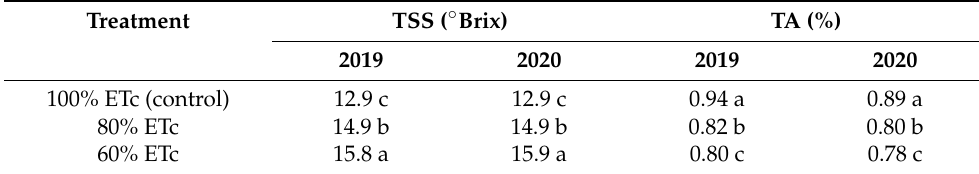
Table 6. Effect of deficit irrigation (as a percentage of crop evapotranspiration, ETc) on total soluble solids (TSS) and total acidity (TA) of ‘African Rose’ plum fruit during the 2019 and 2020 seasons ( n = 10).